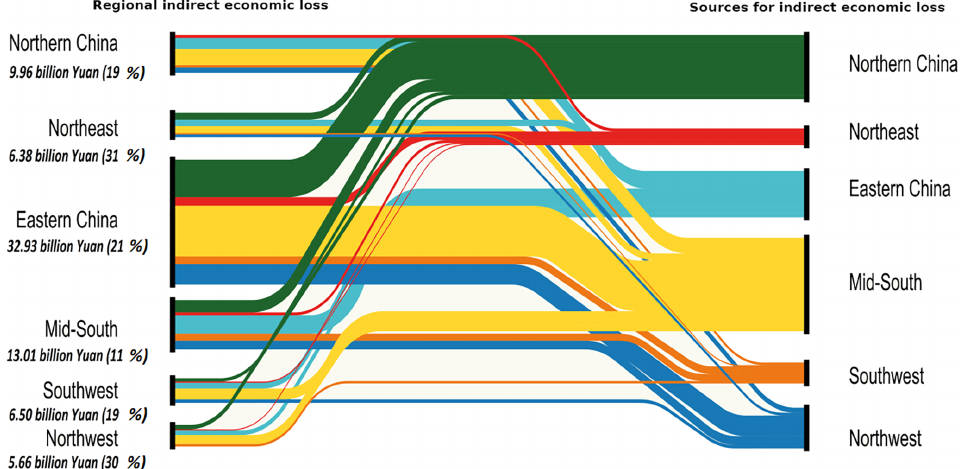
Figure 3. Cross-regional economic loss analysis. The diagram demonstrates the interregional economic impacts due to their interdependen- cies. The left-hand side shows the regional indirect economic loss while the right-hand side denotes the sources for these indirect economic losses. The proportion of regional indirect loss among regional total economic loss is displayed next to each region’s name on the left-hand